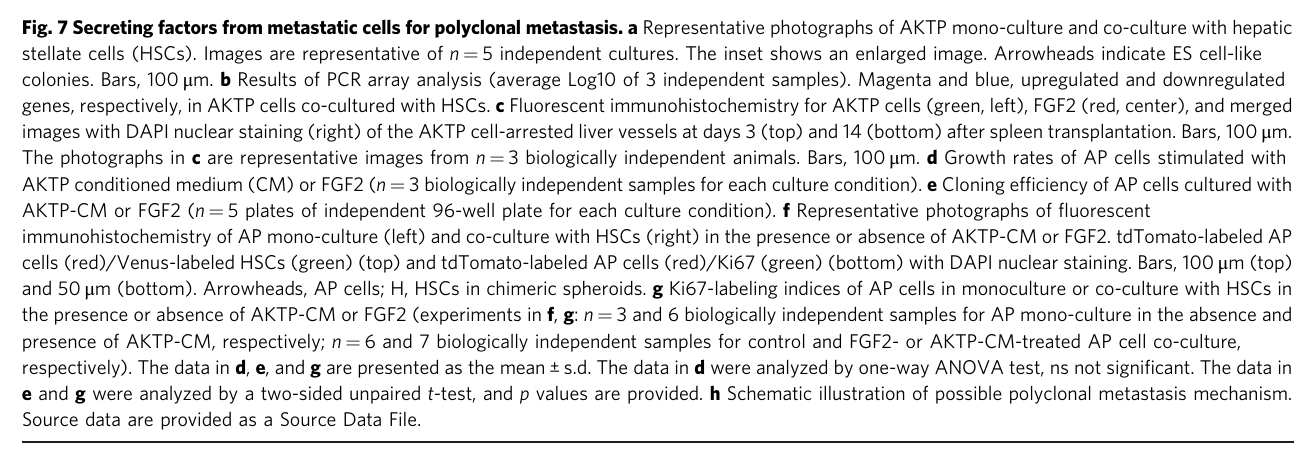
Fig. 7 Secreting factors from metastatic cells for polyclonal metastasis. a Representative photographs of AKTP mono-culture and co-culture with hepatic stellate cells (HSCs). Images are representative of n = 5 independent cultures. The inset shows an enlarged image. Arrowheads indicate ES cell-like colonies. Bars, 100 μ m. b Results of PCR array analysis (average Log10 of 3 independent samples). Magenta and blue, upregulated and downregulated genes, respectively, in AKTP cells co-cultured with HSCs. c Fluorescent immunohistochemistry for AKTP cells (green, left), FGF2 (red, center), and merged images with DAPI nuclear staining (right) of the AKTP cell-arrested liver vessels at days 3 (top) and 14 (bottom) after spleen transplantation. Bars, 100 μ m.